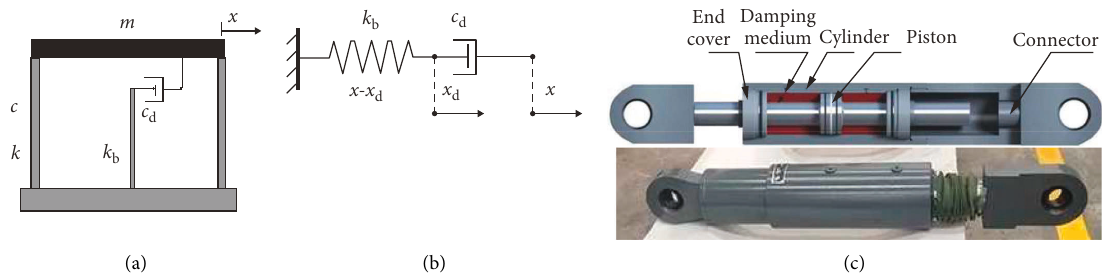
Figure 1: (a) Model for the SDOF system with VDs; (b) Maxwell model; (c) prototype of viscous